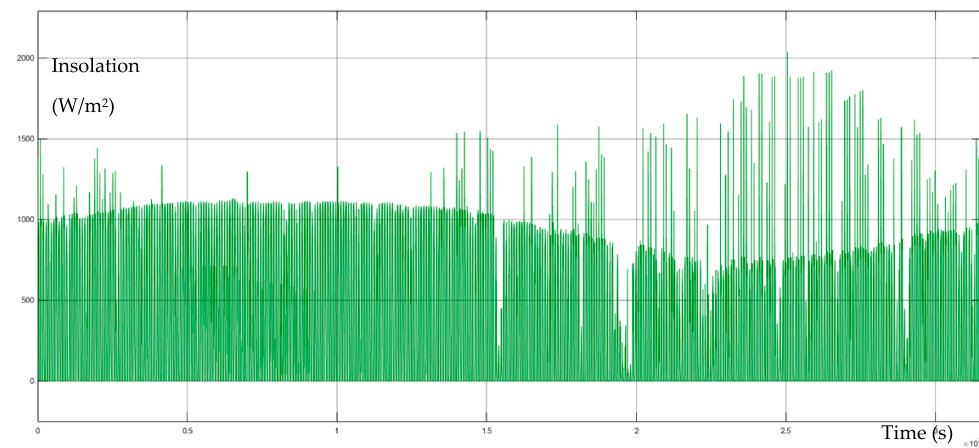
Figure 3. Insolation (W/m 2 ) in Gnaraloo city, Australia during the year 2020, starting from April.